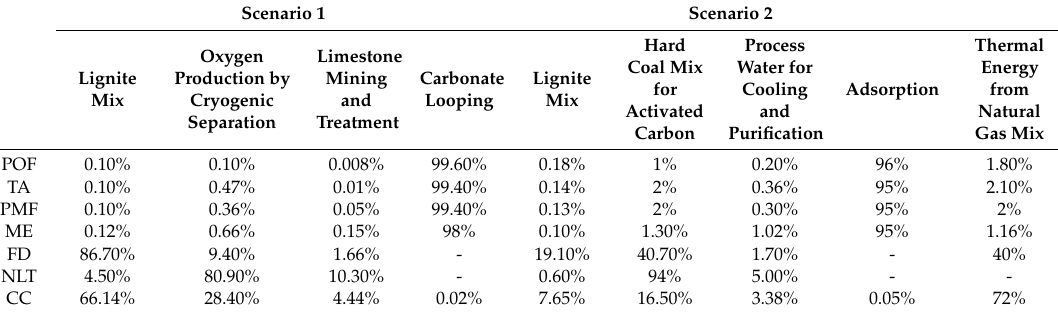
Figure 4. Pareto analysis for scenario 2 (only visible values). Table 9. Relative contribution of the processes to significant environmental categories.